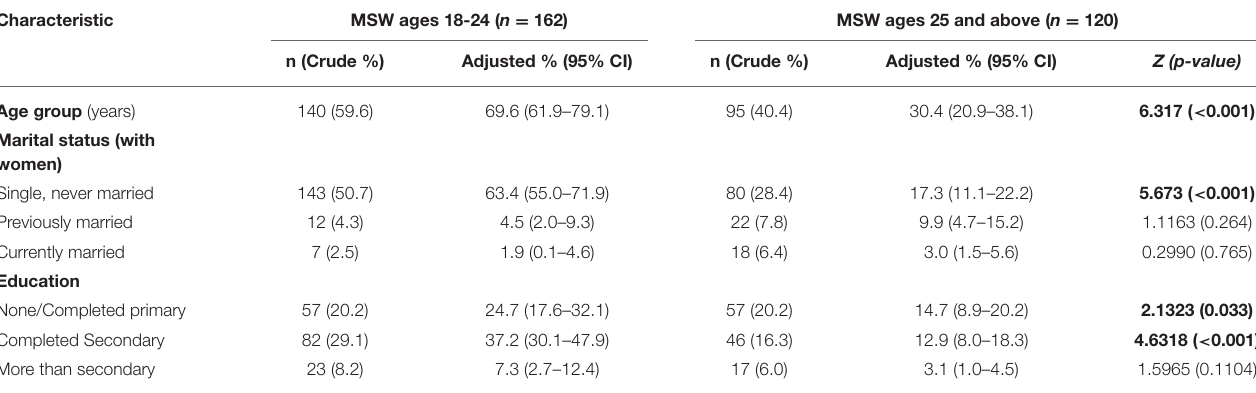
TABLE 1 | Socio-demographic characteristics of MSW who sell sex to other men in Nairobi, Kenya. Characteristic MSW ages 18-24 ( n =